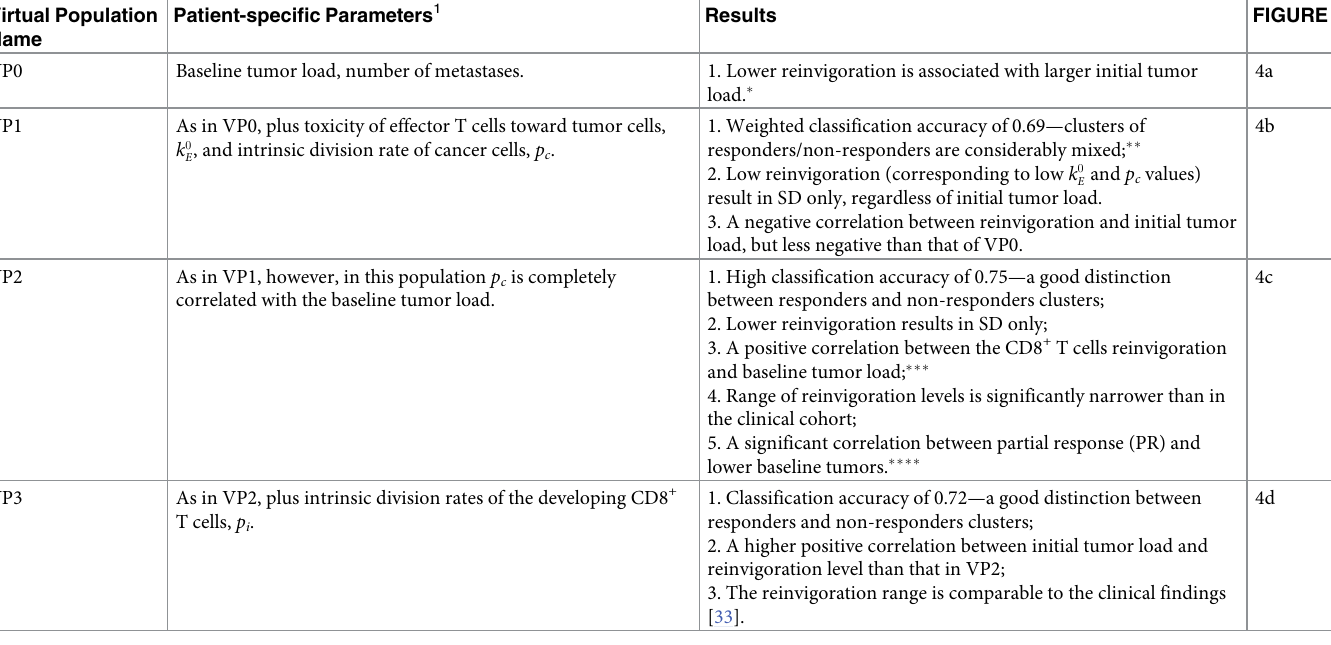
Table 1. Properties and response of the virtual